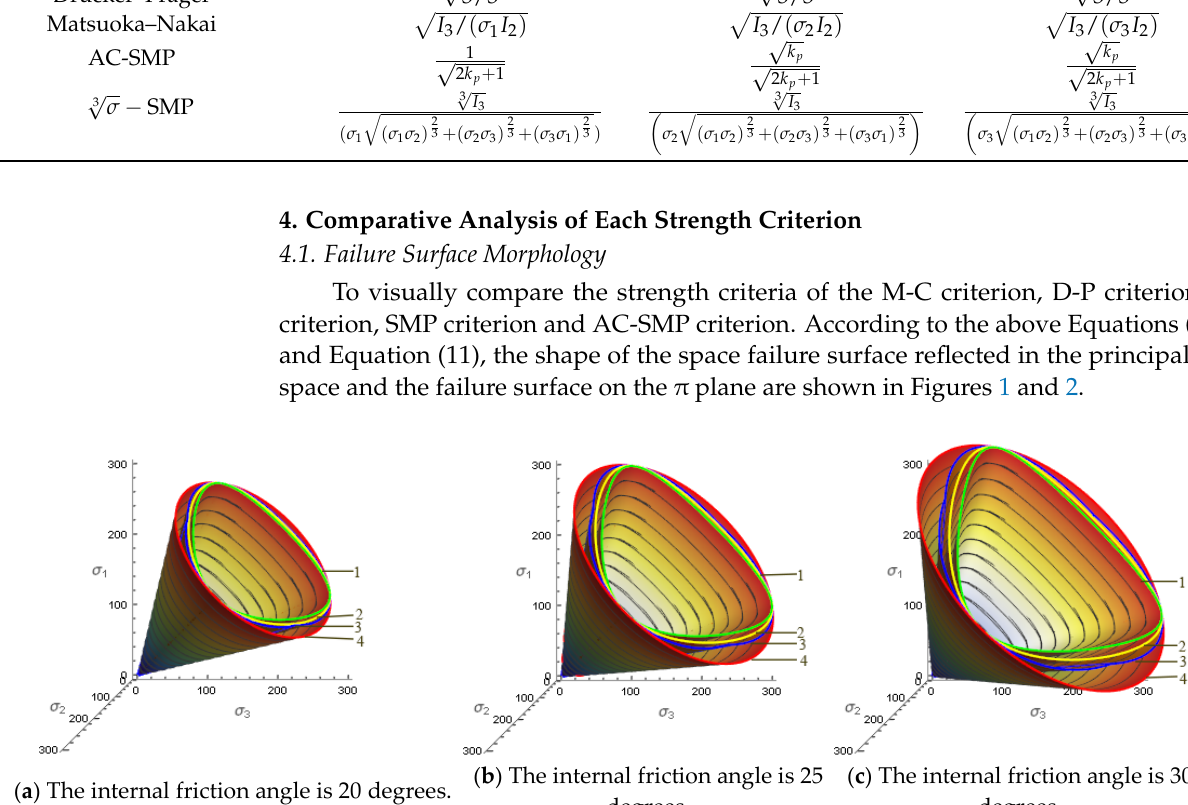
Figure 1. Three-dimensional failure surface morphology summary diagram of each strength criterion under different internal friction angles, 1 — SMP criterion; 2 — L-D criterion; 3 — AC-SMP criterion; 4 — D-P criterion. ( a ) The internal friction angle is 20 degrees; ( b ) The internal friction angle is 25 degrees; ( c ) The internal friction angle is 30 degrees.